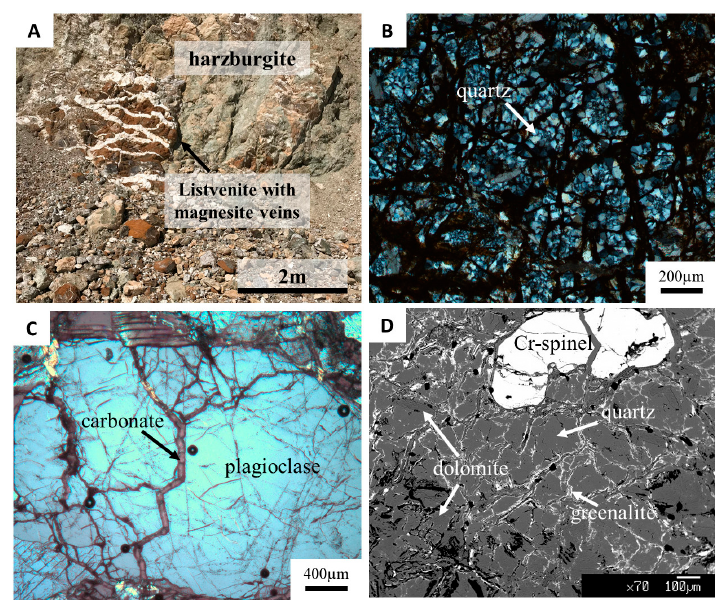
Figure 6. Optical characteristics of listvenites: ( A ) outcrop picture of a listvenite from the Rachoni mine; ( B , C ) the optical microscopy (crossed polars) images of listvenites from an Rachoni open pit (samples W2 and W1); and ( D ) back-scattered image of a listvenite from the Ugo (W17) open pit. Sample W3 is constituted by a serpentine matrix with abundant plagioclase, carbonates and amphiboles. Plagioclase forms euhedral crystals often presenting the characteristic albite polysynthetic twinning (Figure 7A,B,D). Magnesite is the prevalent carbonate and forms colorless anhedral grains (Figure 7A,B). Serpentine is present in the aggregates of pseudomorphic crystals with a lamellar colorless to pale green structure, with low relief and low birefringence (Figure 7A,B). The few primary silicate relicts are mainly represented by rounded and intensely fractured olivine relics (Figure 7C). Minerals 2020 , 10 , x FOR PEER REVIEW